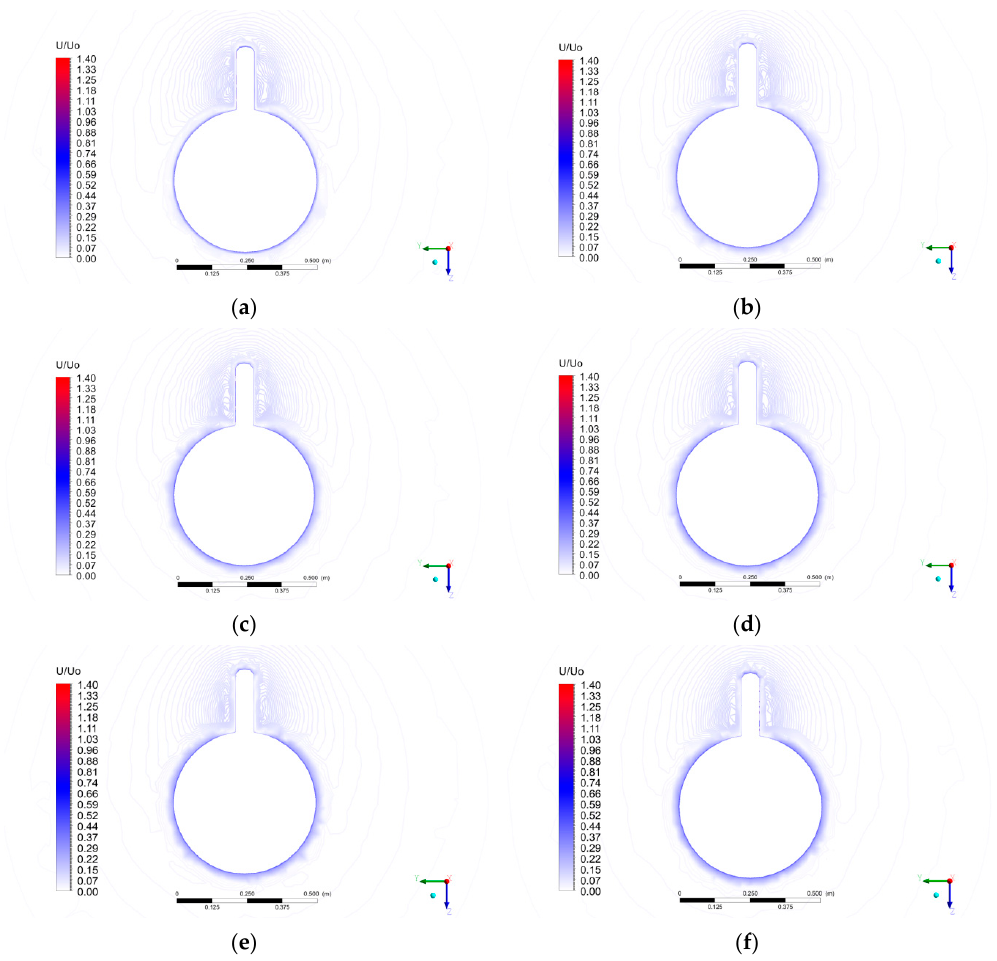
the SUBOFF model under towing speeds of ( a ) 3.05 m / s; ( b ) 5.144 m / s; ( c ) 6.096 m / s; ( d ) 7.16 m / s; Figure 10. The normalized velocity contours around the cross-section of the sail at x / L = 0.255 of the ( e ) 8.23 m / s; and ( f ) 9.151 m / s at t = 30 SUBOFF model under towing speeds of ( a ) 3.05 m/s; ( b ) 5.144 m/s; ( c ) 6.096 m/s; ( d ) 7.16 m/s; ( e ) 8.23 m/s; and ( f ) 9.151 m/s at t = 30 s.